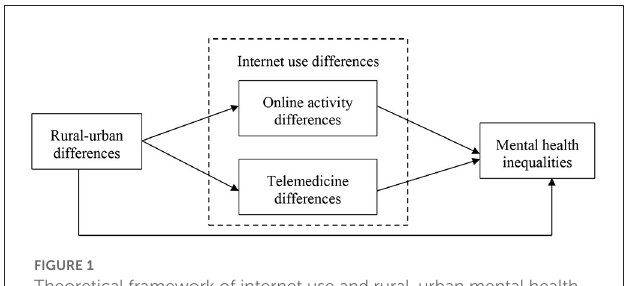
FIGURE1 Theoretical framework of internet use and rural-urban mental health inequalities.